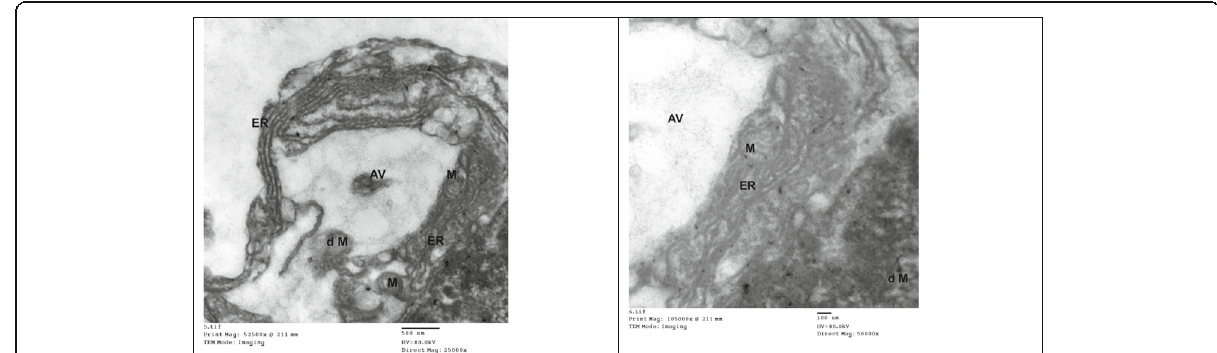
Fig. 8 Ultra-thin section in Allium cepa root tip meristems shows the effect of 3 h of direct treatment with 20.0% yeast extract on cell organelles: mitochondria (M), dilated mitochondria (dM), and accumulated endoplasmic reticulum (ER) wrapped around other undistinguishable organelles in addition to huge autophagic vacuole (AV) with engulfed